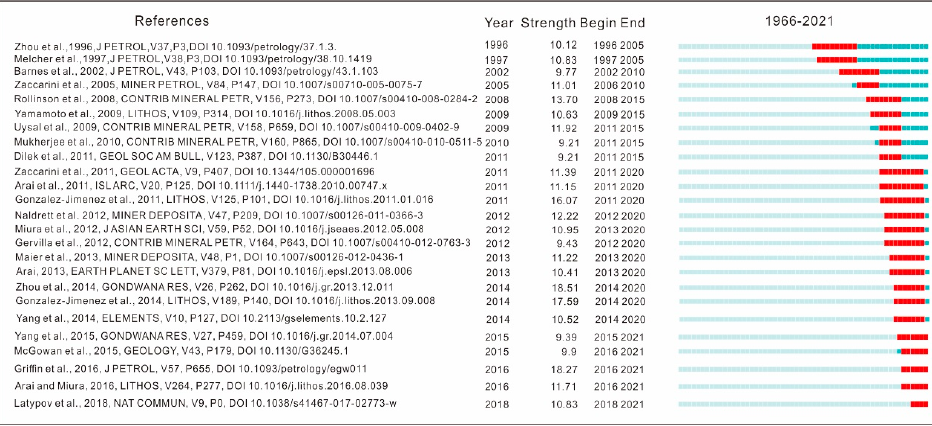
Figure 7. Top 25 references with the strongest citation bursts.